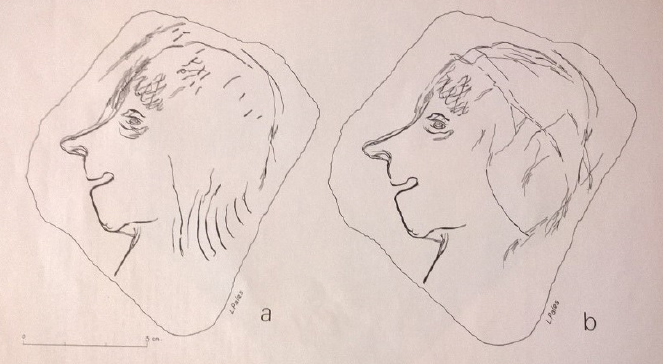
Figure 20. Group γ, example of Hand γ1: Obs. 29(II) (from Pales, 1976).